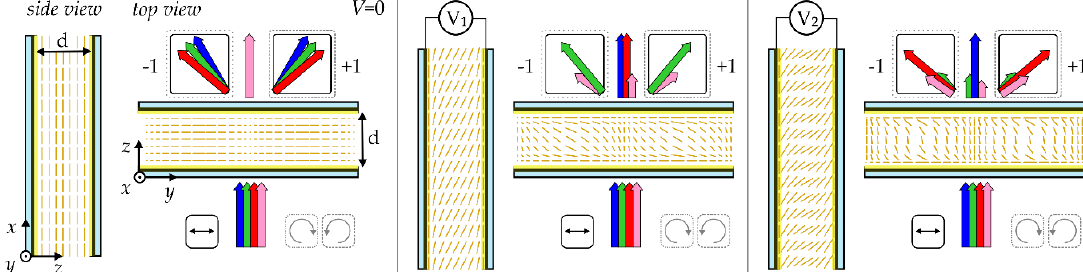
Figure 3. Schematic representation of the diffraction characteristics of exemplified liquid crystalline gratings with the cycloidal director pattern at the cell substrates. Please note that, in general, only the 0 and/or ±1 diffraction orders are present at the output of the LC cell, regardless of input polarization. The wavelengths registered in the specific spots (i.e., diffraction maxima) depend on the sample retardance, specifically with d Δ n eff = m λ for 100% diffraction efficiency in the zeroth—(DE 0 ) and with d Δ n eff = ( m − 1/2)λ for 100% diffraction efficiency in the first- (DE 1 ≡ DE +1 + DE −1 ) diffraction order. The effective birefringence of a liquid crystalline material (Δ n eff ) depends on the wavelength (represented schematically by the arrows of the different colors) and applied voltage. A circularly-polarized beam is diffracted into +1 or −1 order, depending on its handedness, whereas both first orders (±1) are present for a linearly-polarized input beam with their efficiencies (DE +1 and DE –1 ) giving together 100% in the most favorable condition. Shorter arrows at the output of the cell represent the wavelengths which are out of the retardation conditions mentioned above.